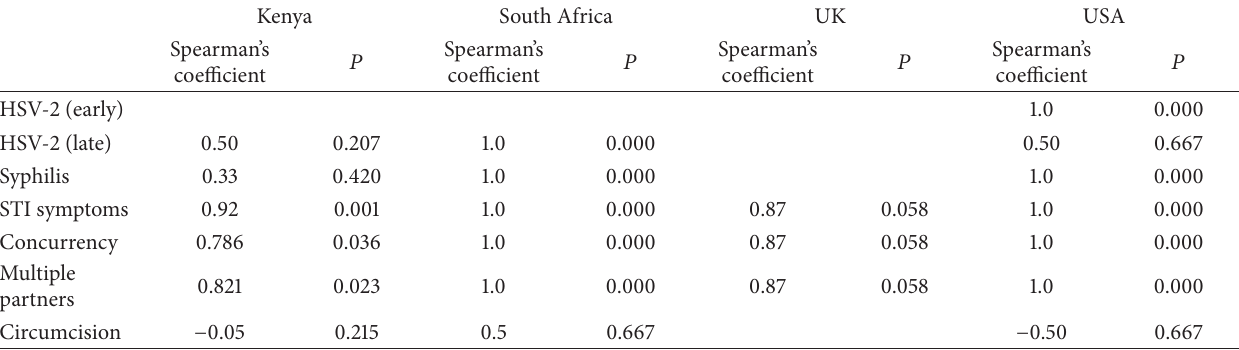
Table 3: Spearman’s correlation coefficient (rho) for the relationship between HIV prevalence and various risk factors and other STIs by racial/ethnic group in Kenya, South Africa, the United Kingdom (UK), and the United States of America (USA).